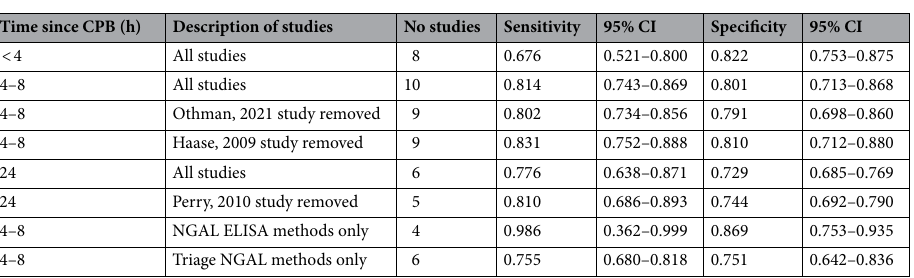
Table 3. Summary points and sensitivity